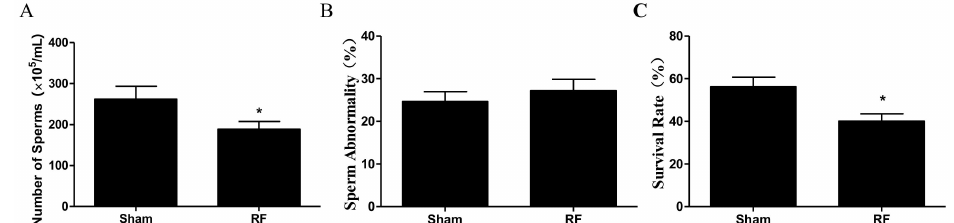
Figure 3. The effect of one-month 220 MHz pulsed modulated RF exposure on sperm quality of SD rats. ( A ) Number of sperm cells; ( B ) Sperm abnormality; ( C ) Survival rate. N = 12 for each group. The values were expressed as mean ± SEM and were analyzed by student t -test. * p < 0.05, compared with the sham